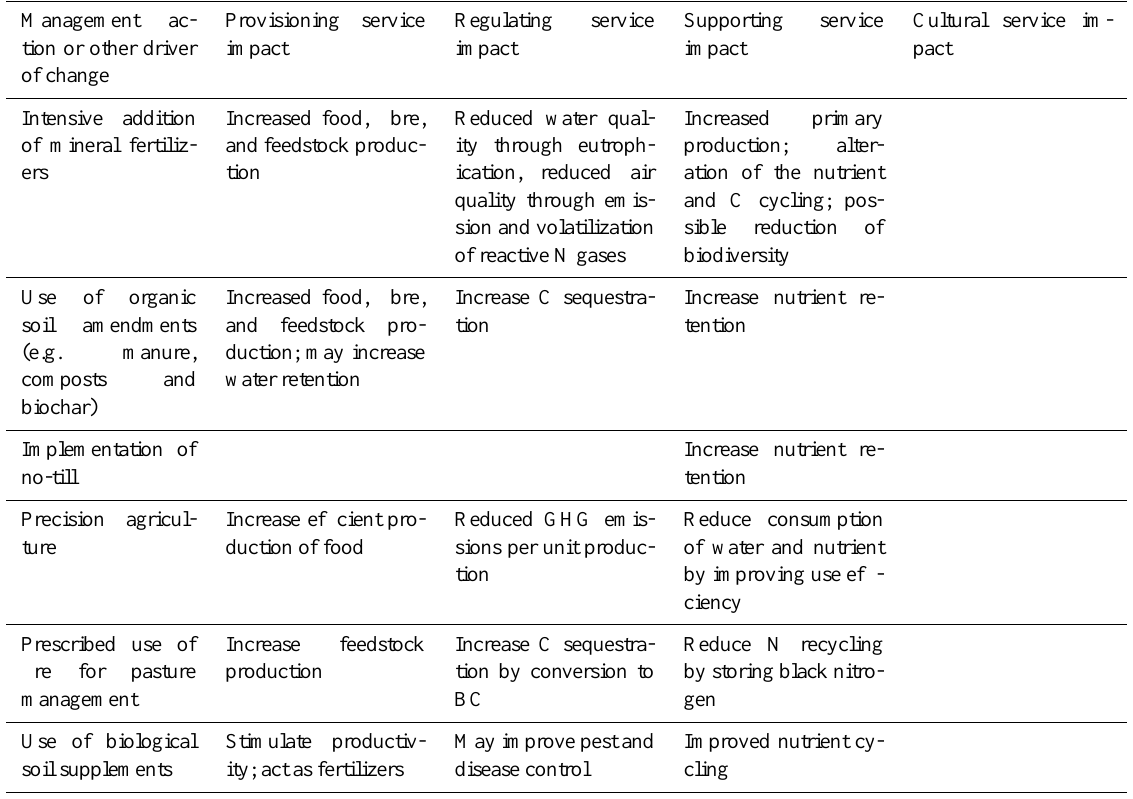
Table 2. Management actions affecting soil nutrient cycles and their impact on ecosystem